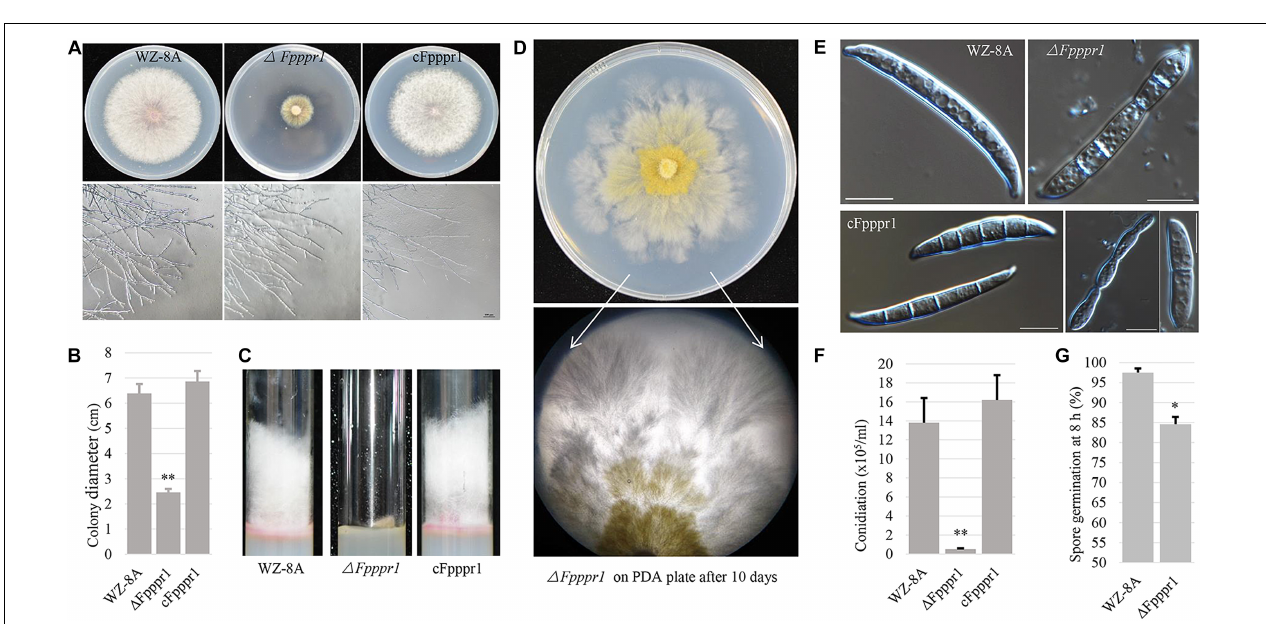
FIGURE 3 | Characteristics of wild type (WZ-8A), (cid:49) Fpppr1 , and cFpppr1. (A) Colony phenotype with and mycelial branching patterns on PDA 3 d after inoculation; (B) Colony diameter measurement on PDA 3dpi (day post inoculation). (C) Comparison of aerial hyphal formation in culture tube. (D) Sectoring of colonies on a PDA plate. (E) Spore morphology. (F) Conidia produced in CMC media with inoculation of fungal plugs for 4–5 d with shaking at 25 ◦ C. (G) Germination of spore suspensions on glass slides at room temperature with quantification of spore germination after 8 h. The asterisk indicates significance ( ∗ p < 0.05, ∗∗ p < 0.01).